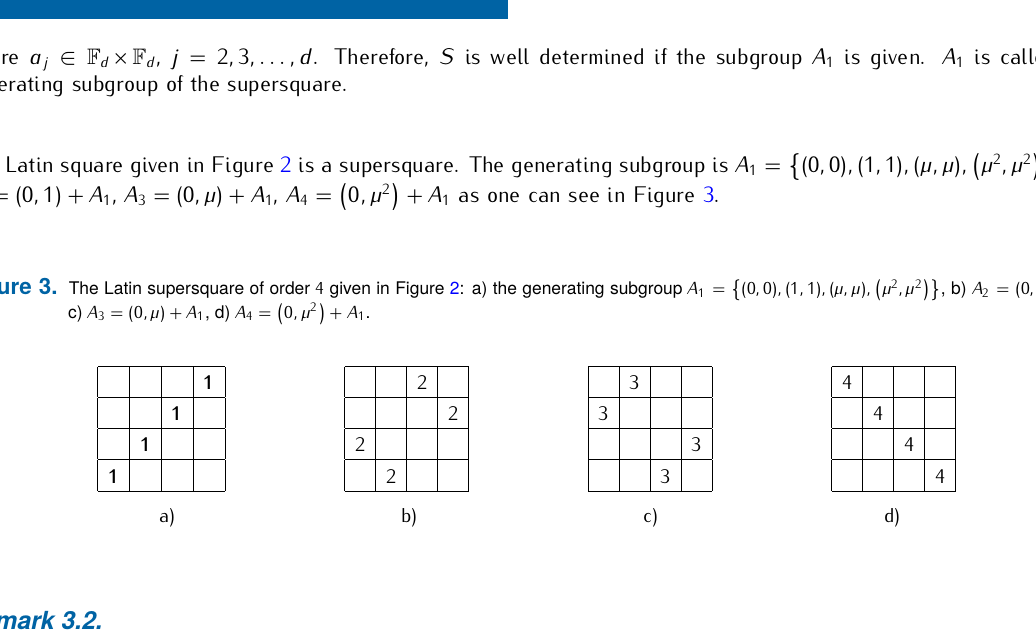
4 given in Figure 2: a) the generating subgroup A 1 =